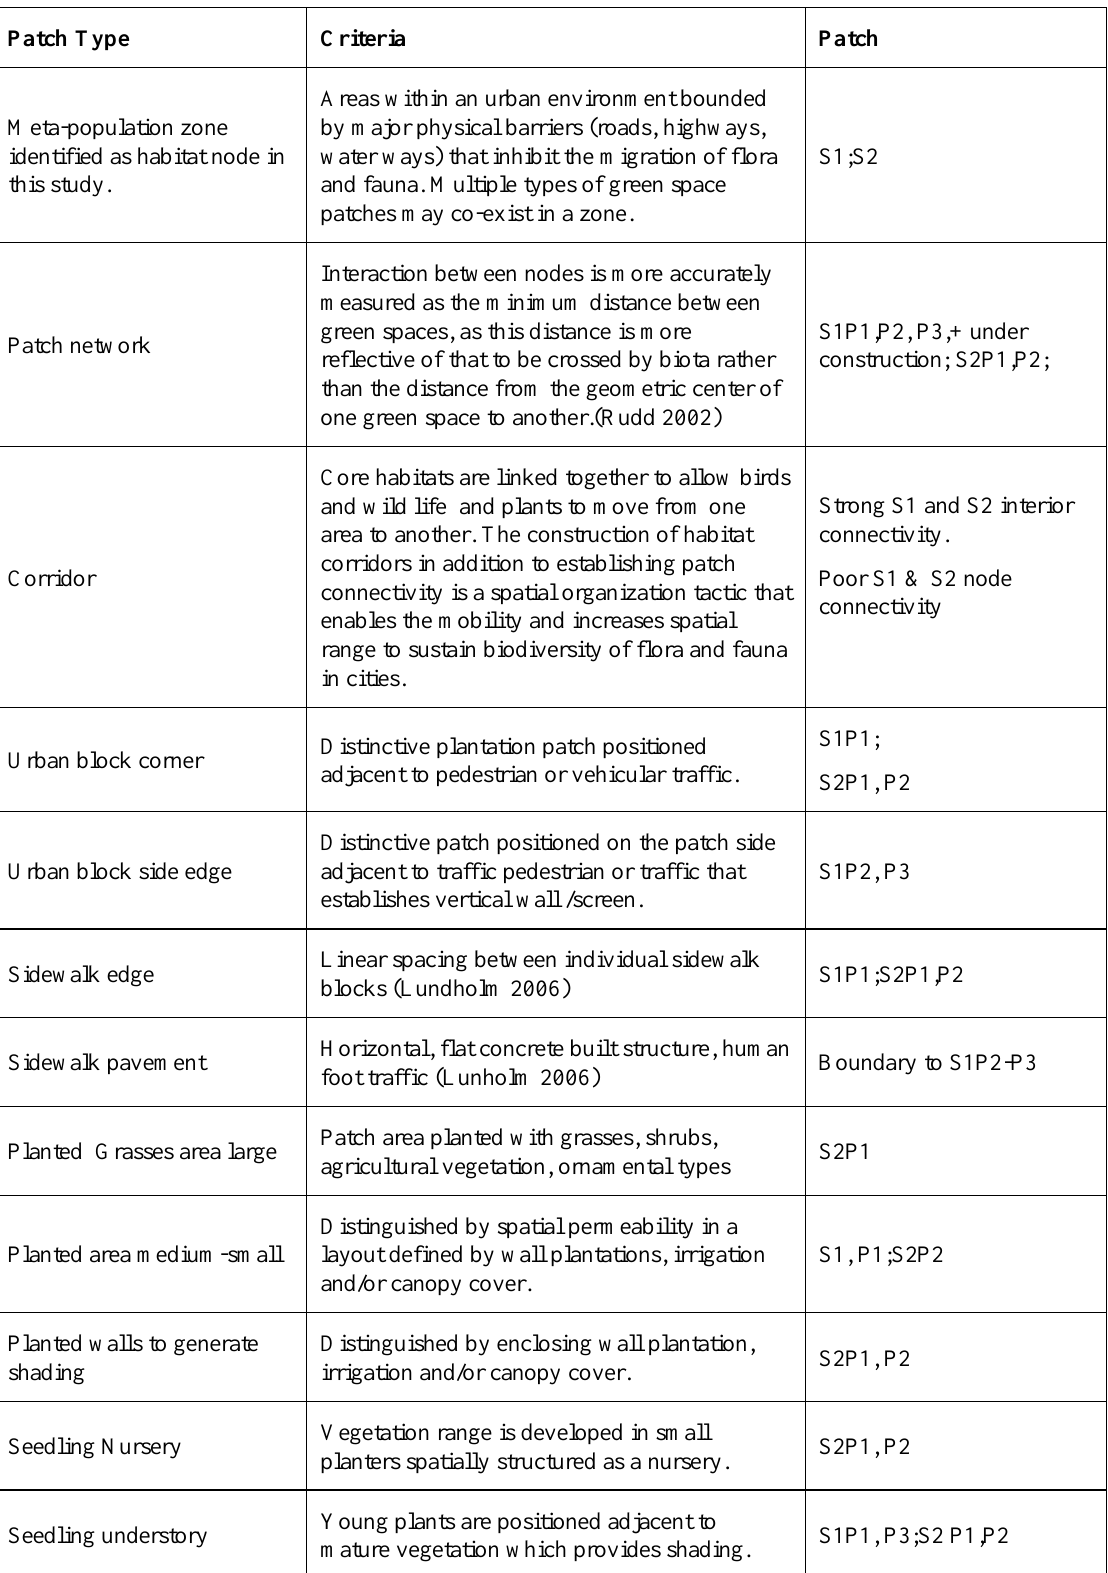
Table 7.Typology of spatial structures found in this study of heterogeneous constructed